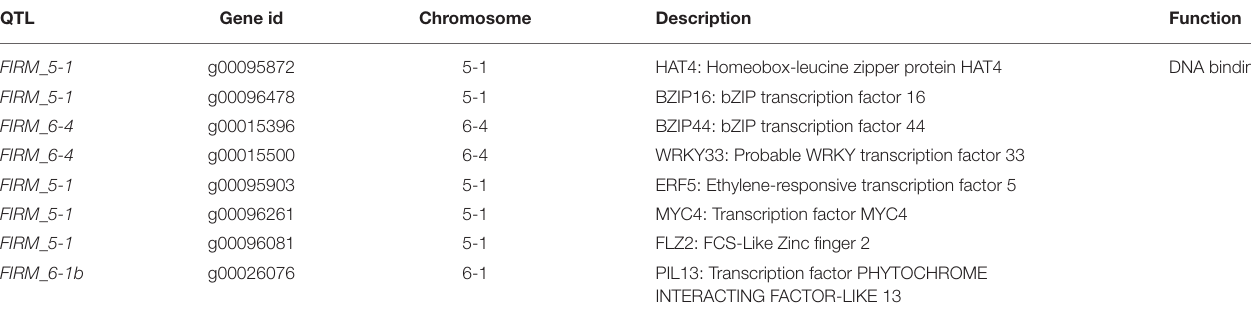
TABLE 4 | Predicted candidate regulatory genes in QTLs associated with the firmness in the ‘BS F 2 (II)’ population. QTL